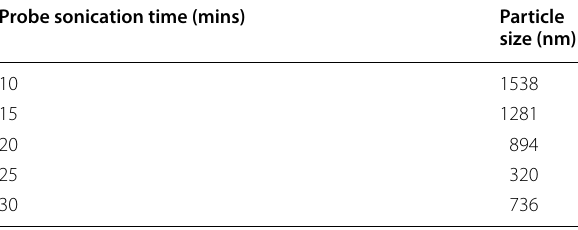
Table 3 Optimization of probe sonication